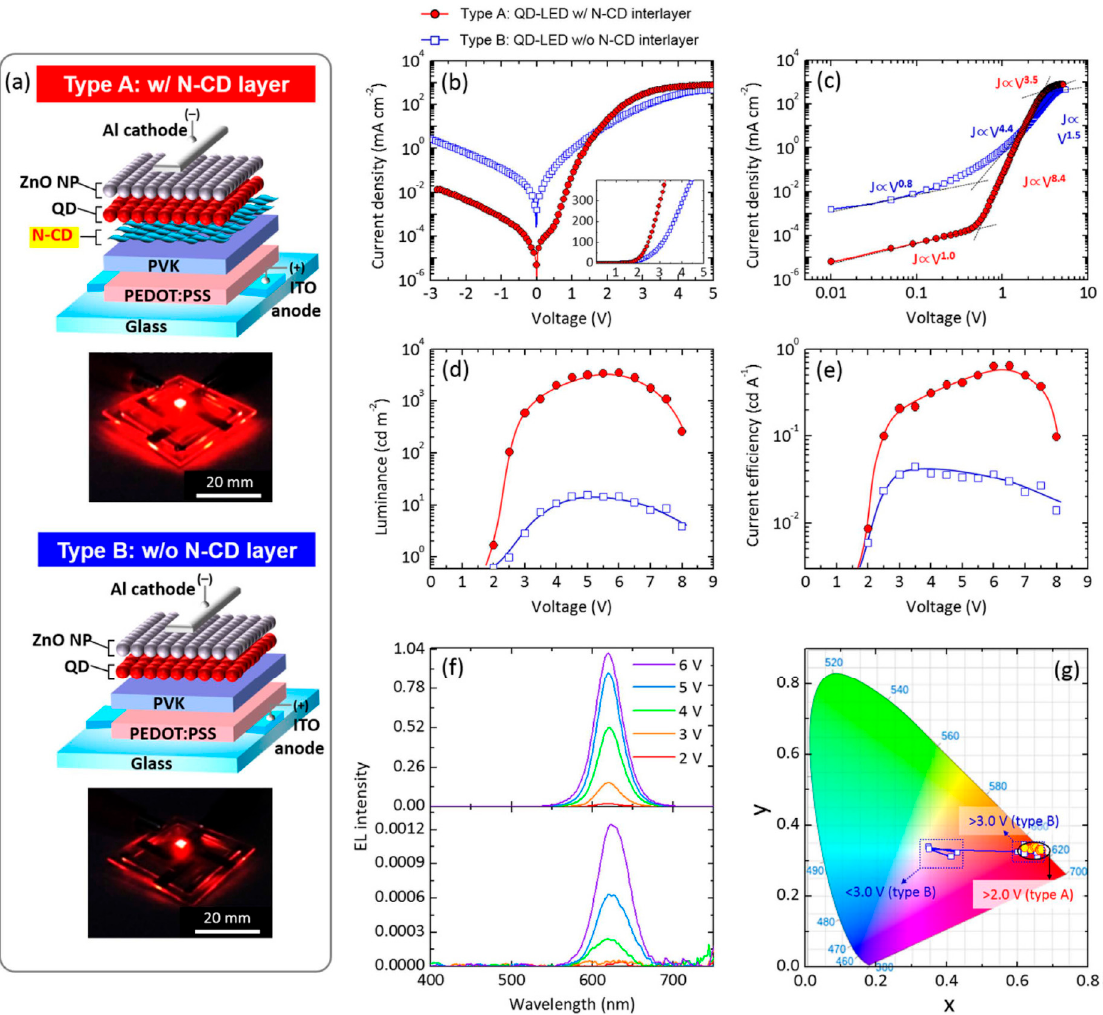
Figure 21. ( a ) Structures of solution-processed quantum dots (QD)-LEDs, with photographs of red emission from both types of QD-LEDs reported; ( b ) J – V characteristic curves, with an inset plotted in a linear scale at forward applied voltages; ( c ) J – V characteristic curves plotted on double-logarithmic axes; ( d ) luminance and ( e ) current efficiency plotted as a function of applied voltage; ( f ) EL spectra of the N-CD-inserted QD-LED (upper panel) and the control QD-LED (lower panel) at diverse applied voltages; and ( g ) CIE coordinates of EL emission colors measured at various applied bias voltages of 2.0–8.0 V: Reproduced with permission from [84], copyright 2019 Springer Nature group.